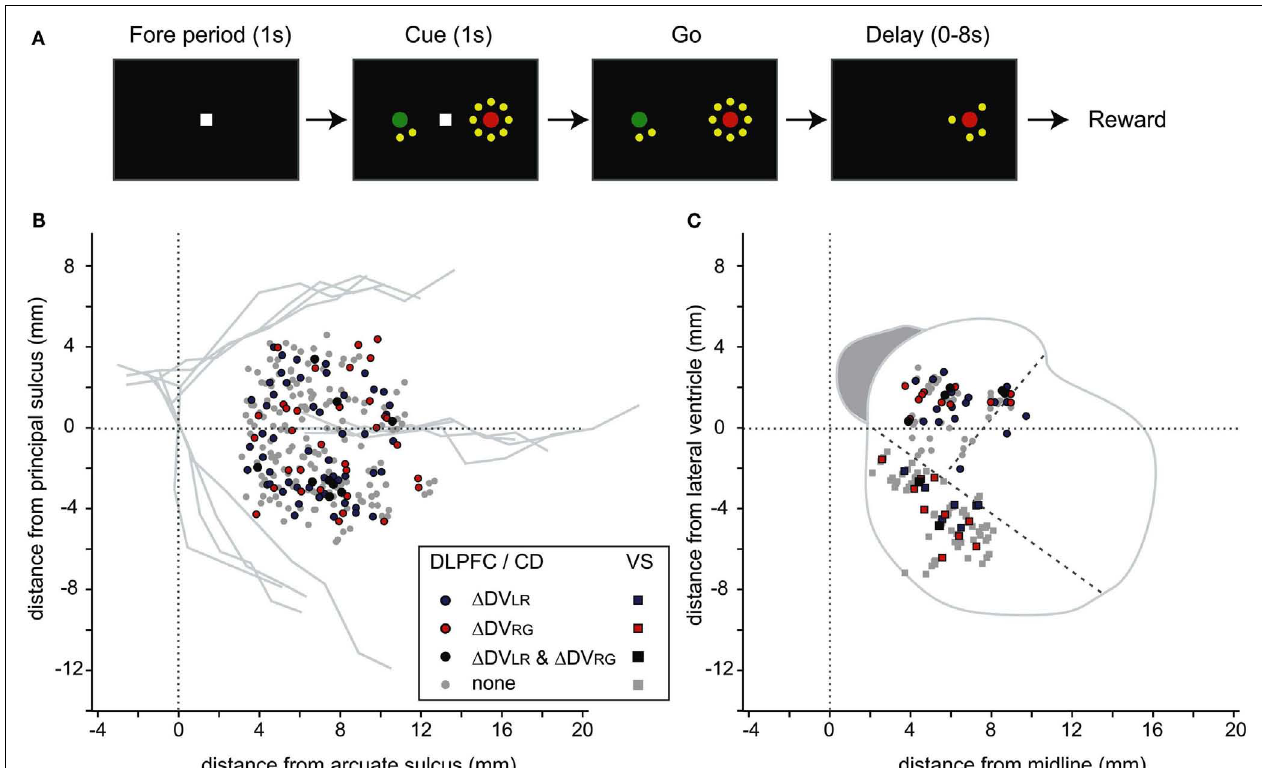
(anterior-posterior) distance is measured relative to the arcuate sulcus, whereas the vertical (dorso-ventral) distance is relative to the principal sulcus. (C) Recording locations for the neurons recorded in the CD andVS. Oblique dotted lines indicate approximately the borders between the CD, VS, and